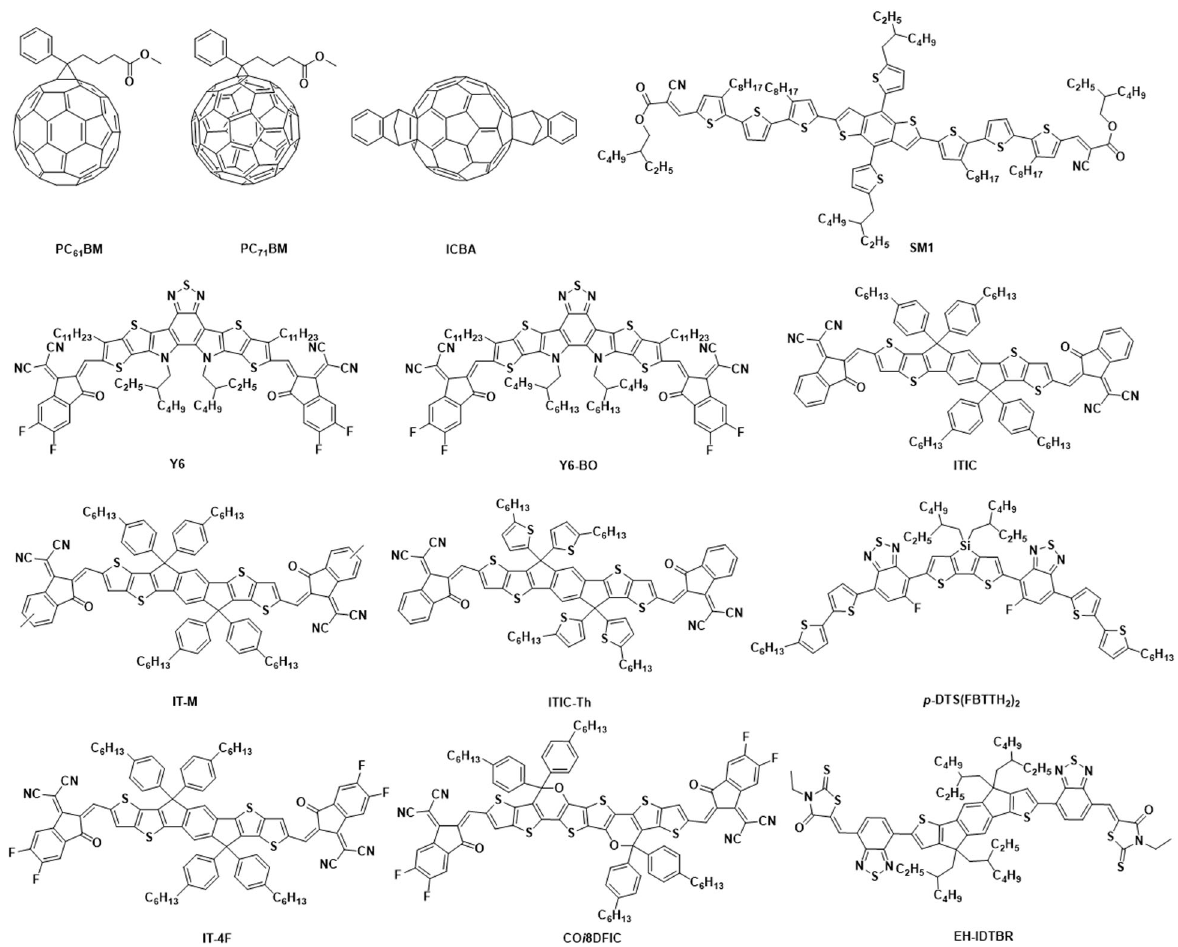
Fig. 4 Acceptors in the photoactive layer. Chemical structures of polymer donors can be used in large-area fl exible